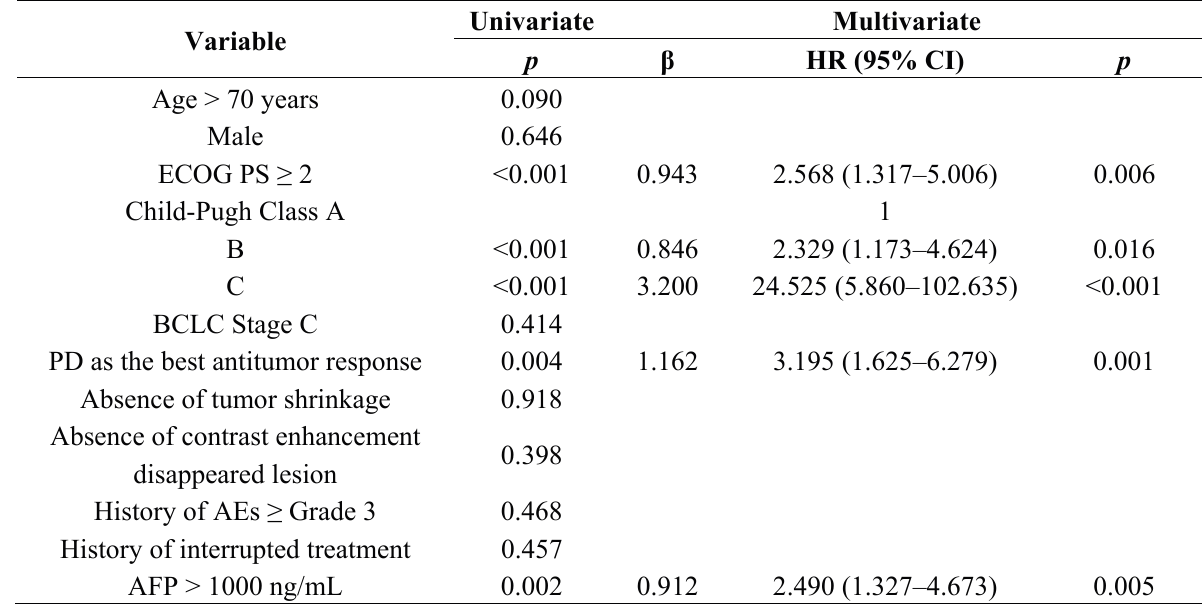
Table 2. Cox proportional hazard model analysis of post-progression survival